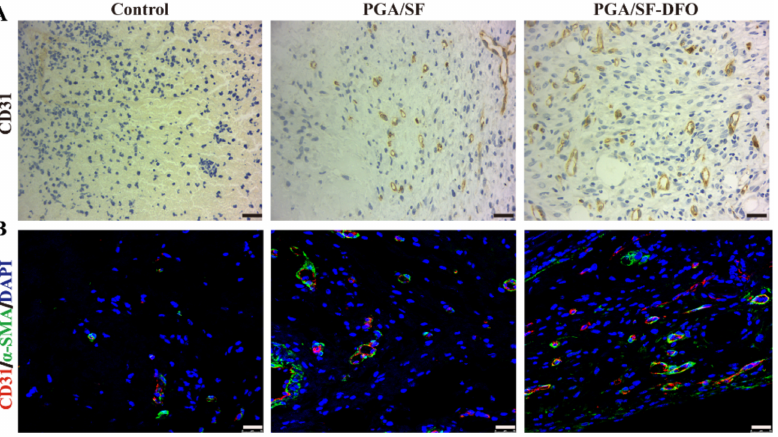
Figure 8. IHC and IF analysis of re-vascularization in wound beds at day 7 post-implantation. ( A ) IHC staining analysis with CD31 and ( B ) IF analysis with CD31 and α -SMA. Scale bar = 25 µ